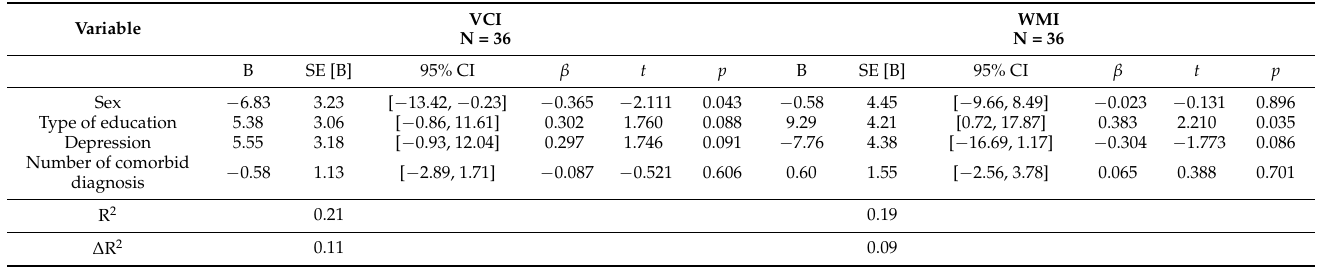
Table 5. Regression coefficients for predicting the VCI and WMI.